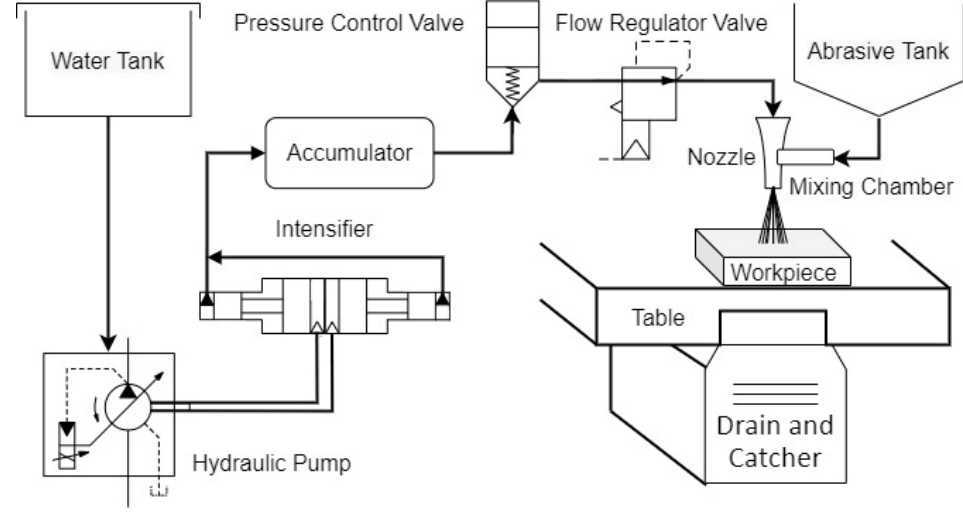
Figure 3. General schematic illustration of an abrasive type of water jet cutting system.